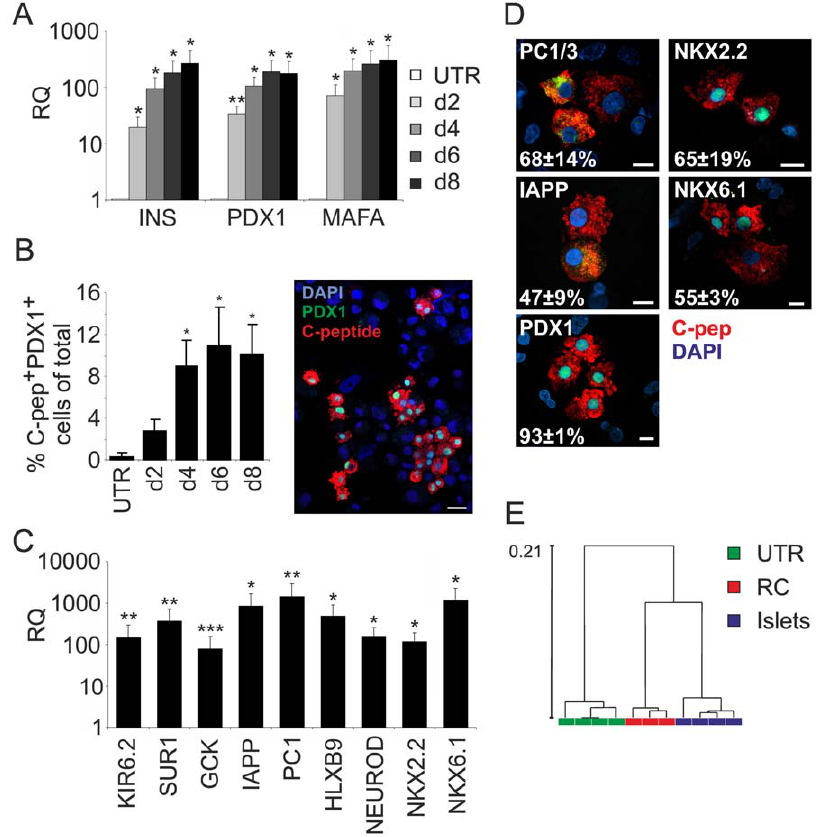
Figure 2. Redifferentiation of BCD cells induced by soluble factors. A,B: Kinetics of induction of beta-cell genes in islet cells at p5 treated with RC. A: qPCR analysis. Values are mean 6 SE relative to untreated cells (d0) (n=3–4 donors) and normalized to human RPLPO or GAPDH. *p , 0.05; **p , 0.01. B: Immunofluorescence analysis of cells co-stained for C-peptide and PDX1. Values are mean 6 SE (logarithmic scale), based on counting . 500 cells from each of 3 donors at each time point. *p # 0.05, relative to untreated cells (d0). A representative micrograph is shown. Bar=25 m m. C,D: Analyses of beta-cell gene expression in islet cells at p5–7 treated with RC for 8d. C: qPCR analysis. Values are mean 6 SE (logarithmic scale) relative to untreated cells (d0) (n=3–4 donors) and normalized to human RPLPO. *p , 0.05; **p , 0.005; ***p , 0.0005. D: Immunofluorescence analysis of cells co-stained for C-peptide and the indicated protein (in green). Bar=10 m m. The percentages indicate the fraction of cells positive for each marker among C-peptide + cells. Data are mean 6 SD, based on counting . 200 cells from each of 3 donors. E: Unsupervised clustering of gene expression patterns detected in cDNA microarray analyses of uncultured islet cells from 4 donors, expanded islet cells at p5 from 4 donors (UTR), and expanded islet cells at p5 from 3 donors treated with RC.